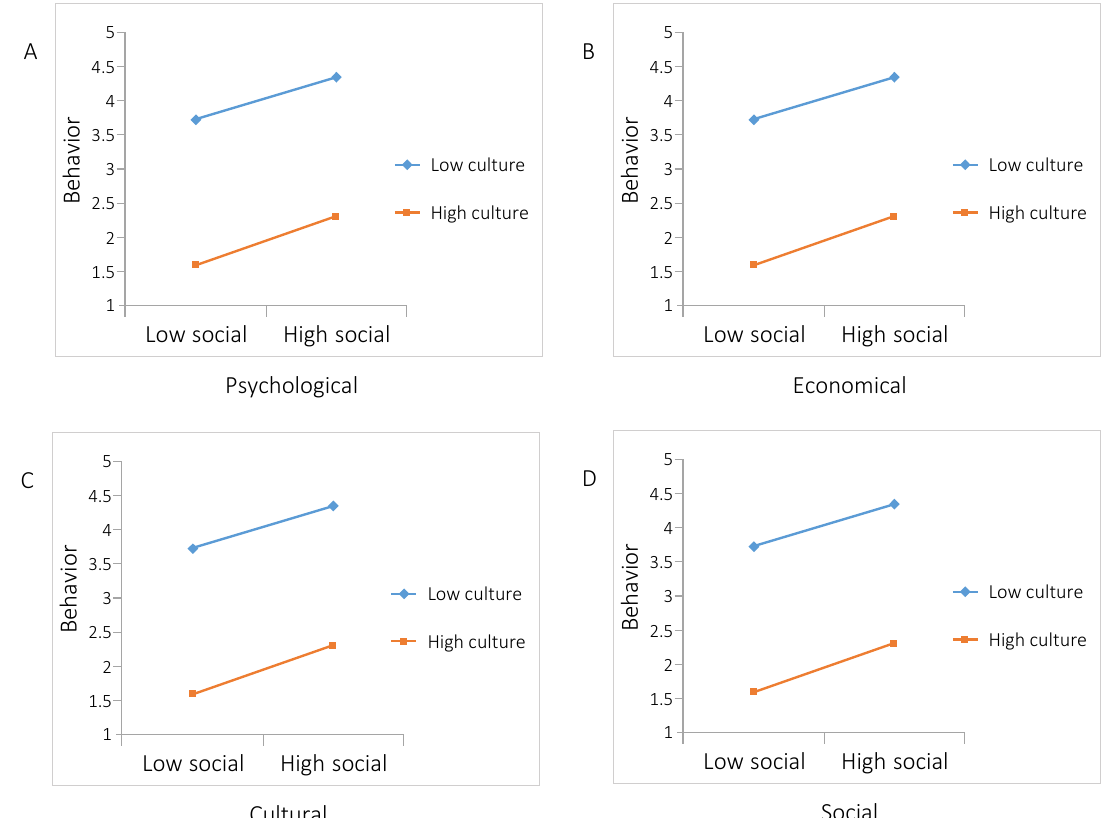
Figure 3. Relationship between the predictor